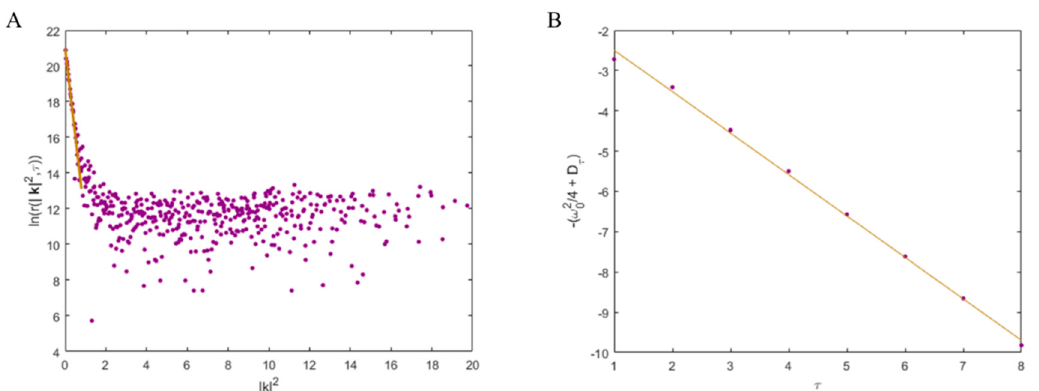
Figure 4. Figures showing kICS correlation function analysis to measure a diffusion coefficient for a labelled molecule in a 2D system. ( A ) An example of a simulated image stack analysed with equation 5 at a given lag time τ . The linear fit is shown for | k | 2 between 0 and 0.8 to obtain the diffusion coefficient for k ‐ vector scales still exhibiting correlation above the noise floor for this time lag. This linear fit slope is measured at multiple τ lag values and plotted versus lag time as seen in ( B ). The slope of this slope versus time lag plot is fit with a linear regression in ( B ) and the diffusion coefficient is the negative of the fit slope value (in this case 1 μ m 2 /s).